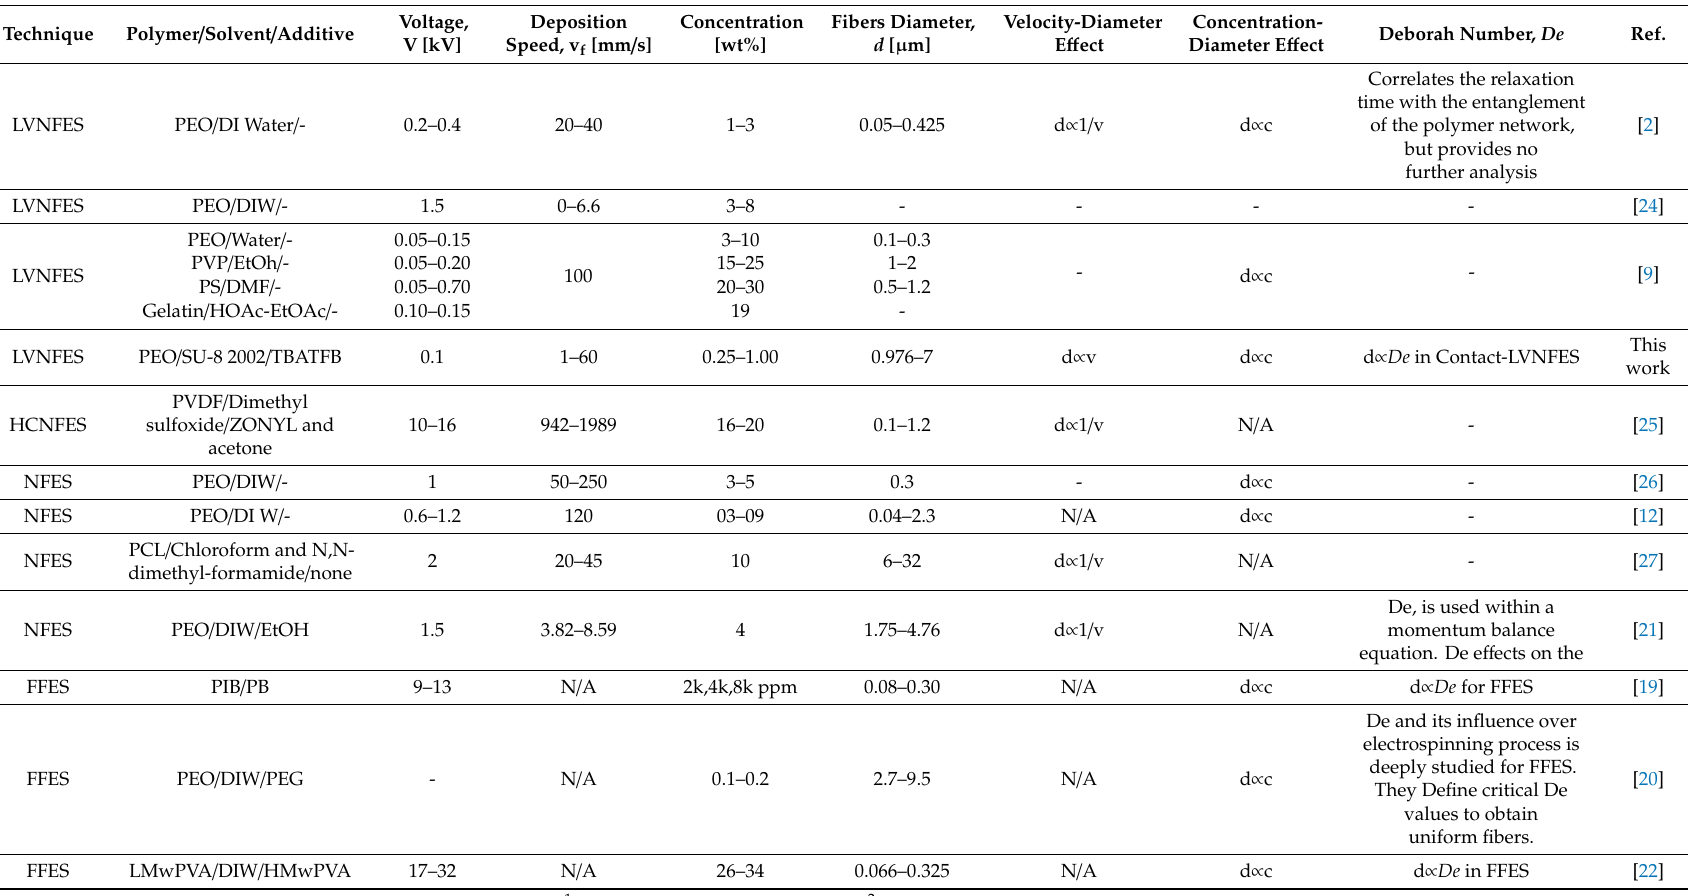
Table 1. Low-voltage near-field electrospinning platform (LVNFES), near-field electrospinning (NFES), and far-field electrospinning (FFES)